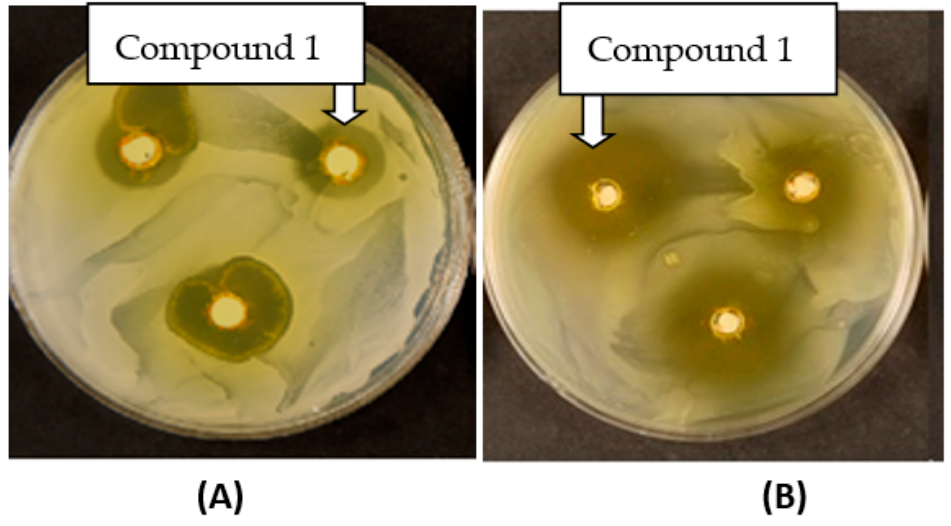
Figure 8. Candida albicans ( A ) and Staphylococcus aureus ( B ) treated with compound 1.